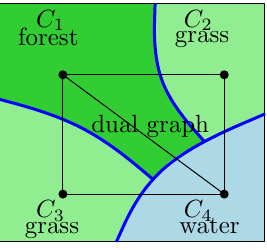
Figure 5: Example of context distance along shortest